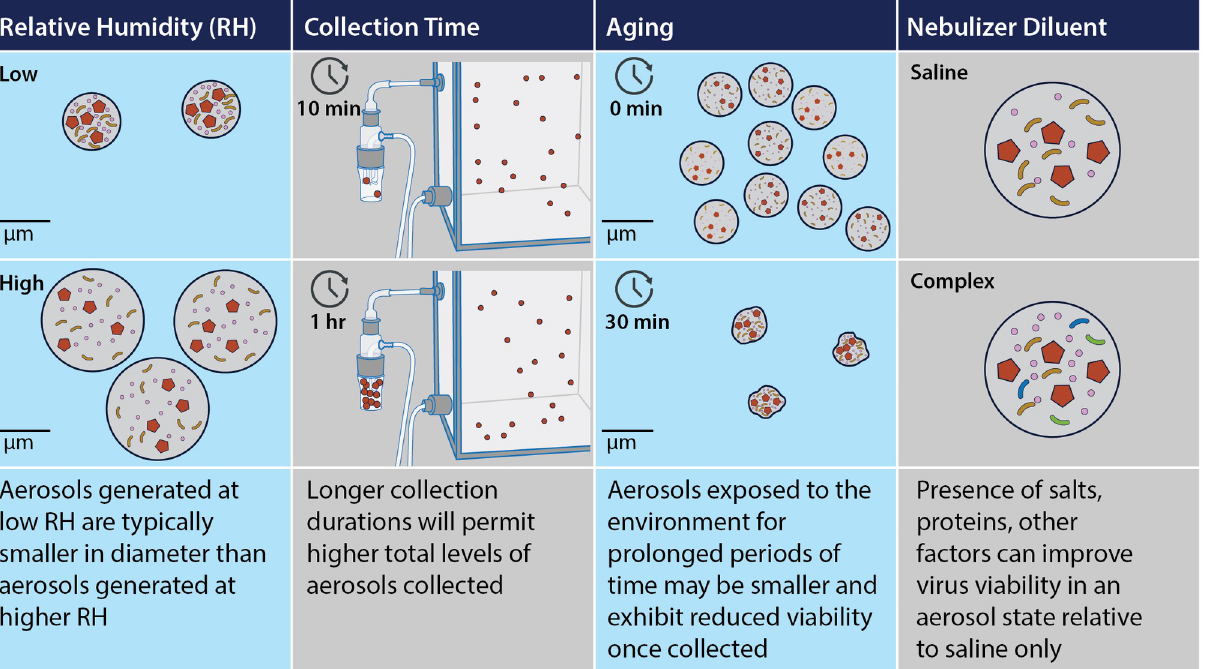
PLOS Pathogens| https://doi.org/10.1371/journal.ppat.1011178 March 9,